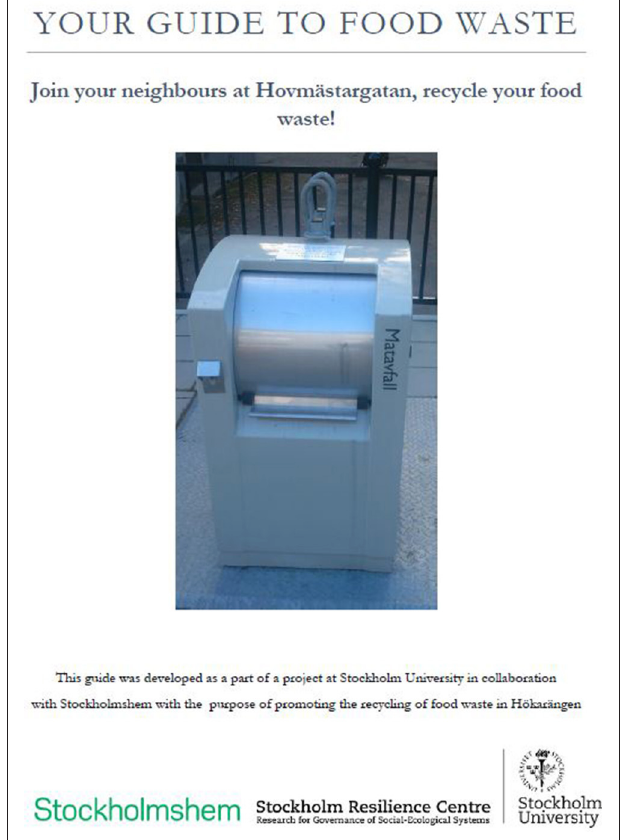
FIGURE 1 | The front page of the information leaflet (translated from Swedish, see the full leaflet Appendix B in Supplementary Material) the picture used was taken by one of the